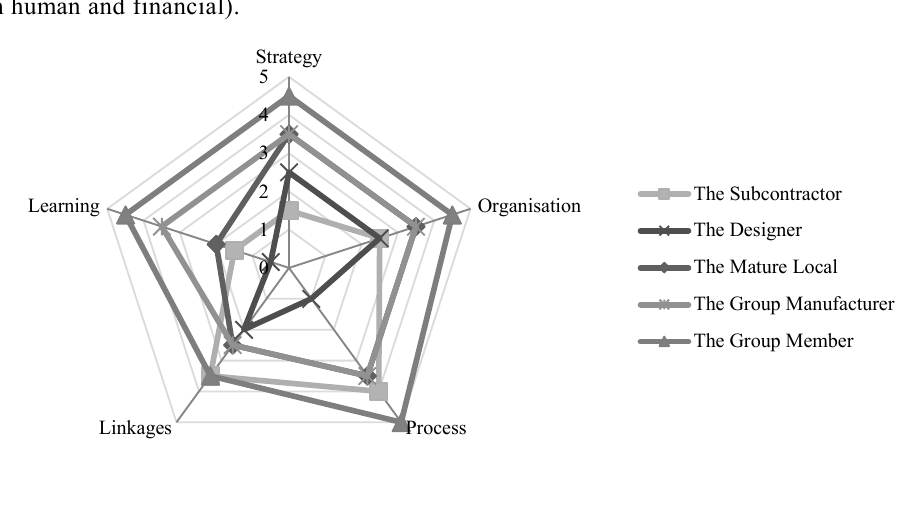
Fig. 3. The results of companies' circular design capacity assessment by